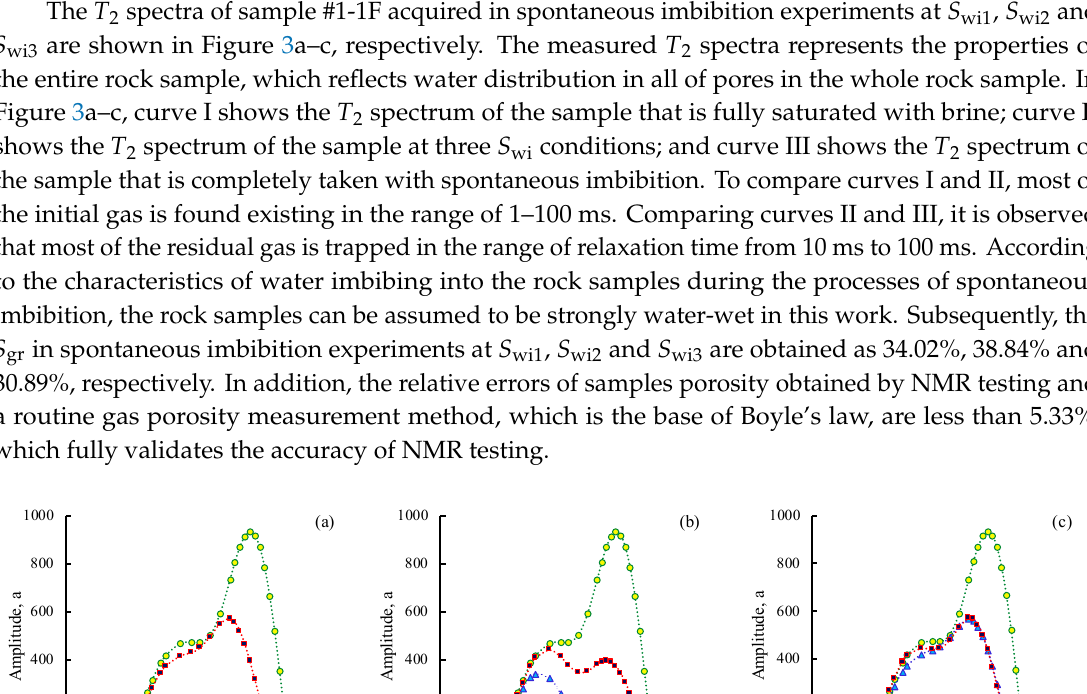
Figure 4. T 2 spectrum of samples #1-1F and #1-2F that measured in the forced imbibition experiments with three S wi and four different flowrates: ( a ) S wi1 = 0; (b) S wi2 = 39.34 ± 1.57%; (c) S wi3 = 62.98 ± 2.22%.